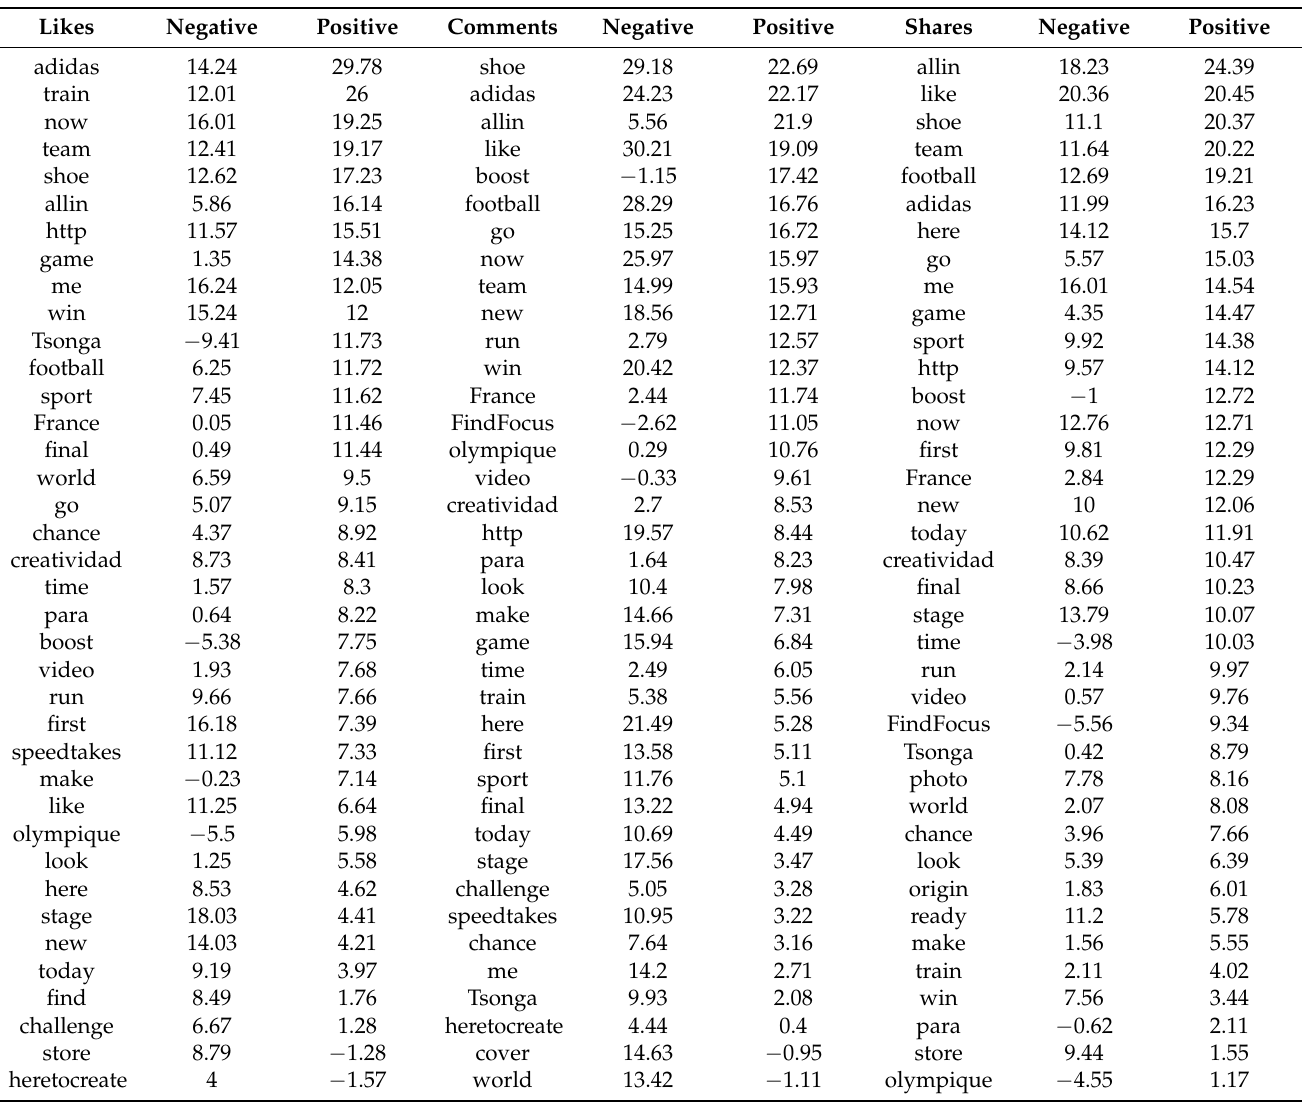
Table A6. Negative and positive cues for